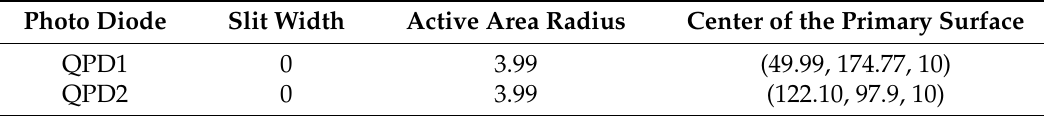
Table 3. Photo diodes. All units in (mm).